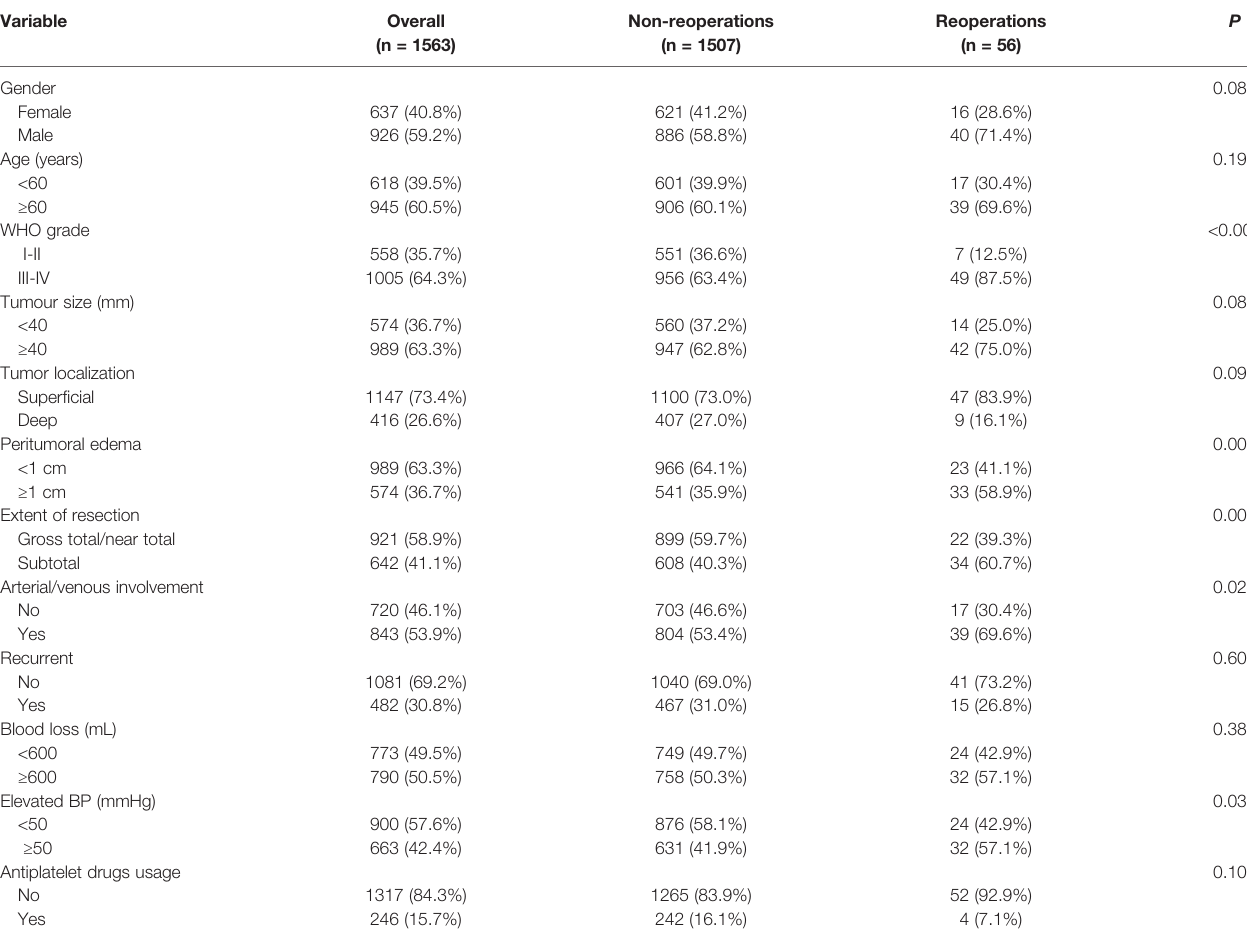
TABLE 1 | Baseline characteristics of the patients.